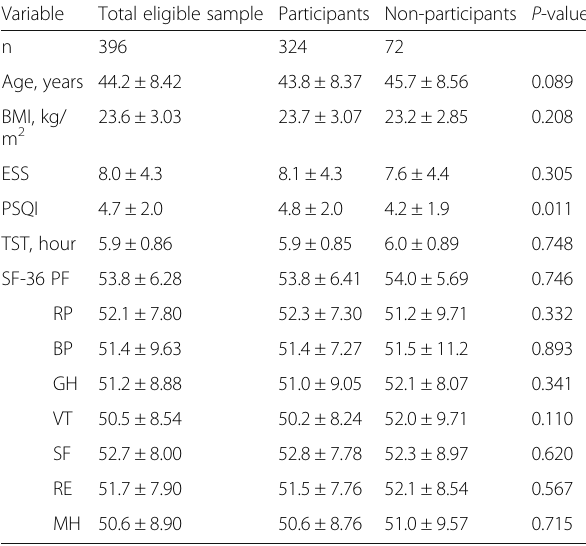
Table 1 Characteristics of study population